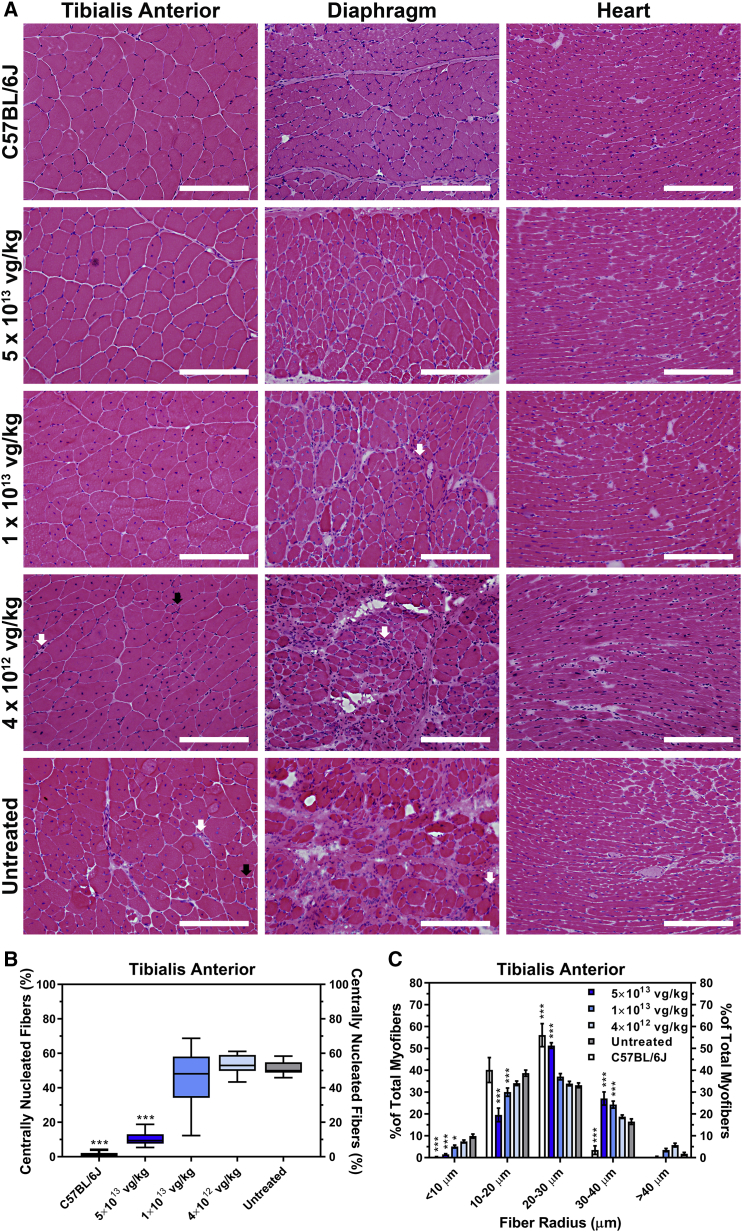
AAV9-FKRP Gene Therapy Rescues Severe Muscle Pathology(A) H&E staining of tibialis anterior, diaphragm, and heart tissue cross-sections acquired from 52-week-old C57BL/6J, AAV9-FKRP-treated (5 × 1013, 1 × 1013, 4 × 1012 vg/kg), and untreated FKRPP448L mice. Myopathic groups of small necrotic (white arrows) and regenerating (black arrows) muscle fibers are illustrated. Scale bars, 200 μm. (B) Quantification of centrally nucleated fibers in the tibialis anterior muscle from 52-week-old C57BL/6J (n = 6), AAV9-FKRP-treated (5 × 1013, 1 × 1013, 4 × 1012 vg/kg), and untreated FKRPP448L cohorts (n = 10). Box-and-whisker plot with Tukey whiskers. ***p ≤ 0.001, one-way ANOVA, Dunnett’s test with each condition versus age-matched untreated FKRPP448L mice. (C) The equivalent radius of individual myofibers in the tibialis anterior muscle from 52-week-old C57BL/6J (n = 6), AAV9-FKRP-treated (5 × 1013, 1 × 1013, 4 × 1012 vg/kg), and untreated FKRPP448L cohorts (n = 10). Error bars represent mean ± SD. *p ≤ 0.05, ***p ≤ 0.001, two-way ANOVA, Dunnett’s test with each condition versus age-matched untreated FKRPP448L mice.